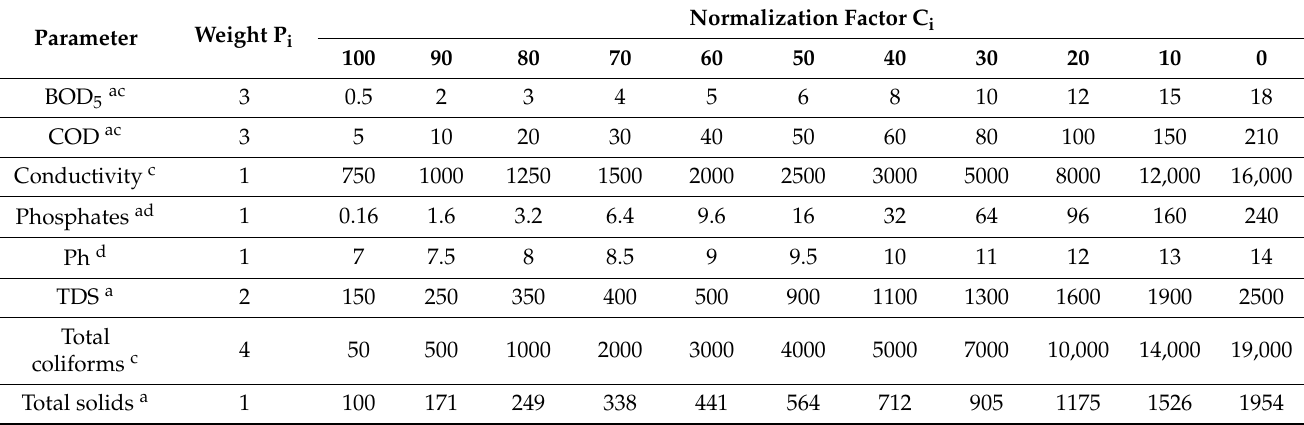
Table 2. Water quality rating weights and normalization